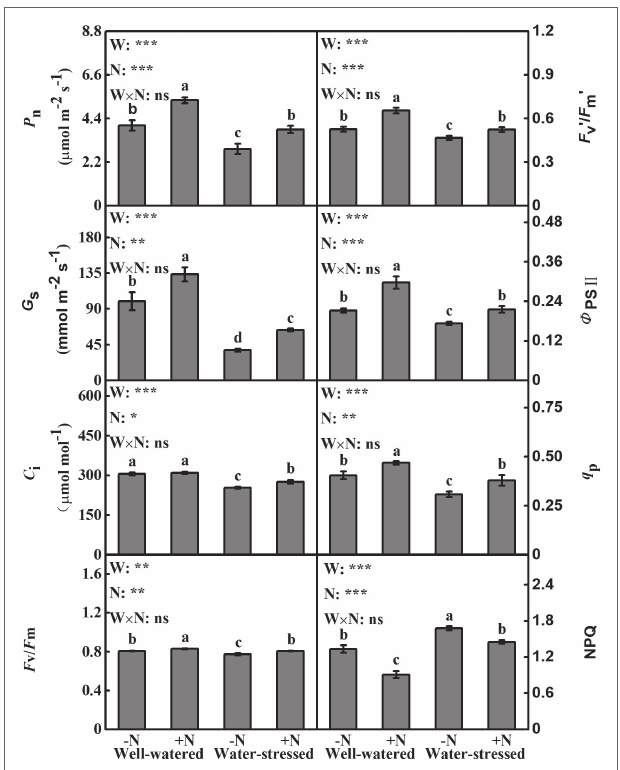
FIGURE 2 | Gas exchange and chlorophyll fluorescence parameters of Fargesia denudata leaves for N non-deposition ( − N) and N deposition (+N) treatments with and without drought stress. F W , water effect; F N , N deposition effect; and F W × F N , interactive effect of water and N deposition. Values with different letters are significantly different at p < 0.05. Vertical bars show ± S.E. Significant levels: *** p < 0.001; ** p < 0.01; * p < 0.05; ns (non-significant) p >